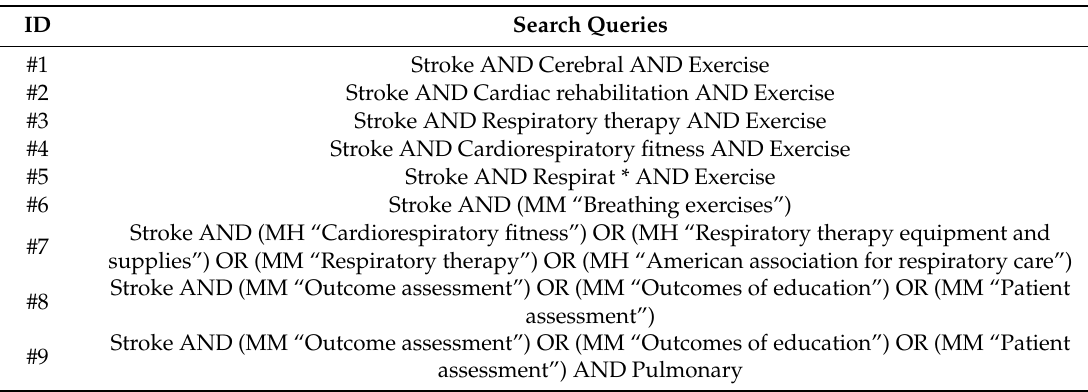
Table 3. Search strategy in